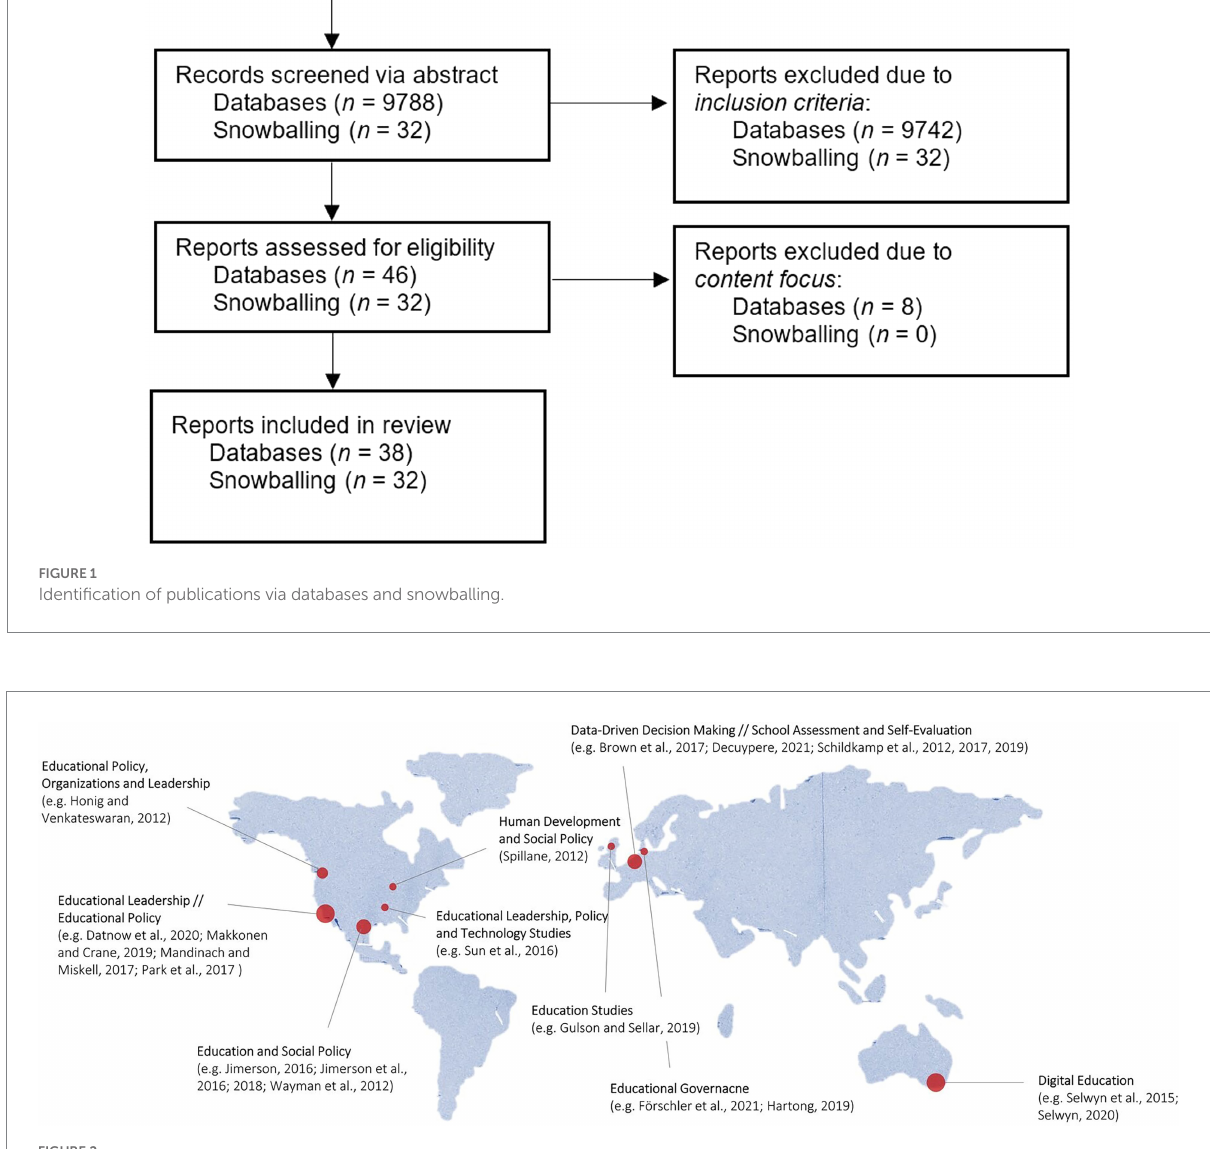
FIGURE 2 Geographical distribution and focus of the publications